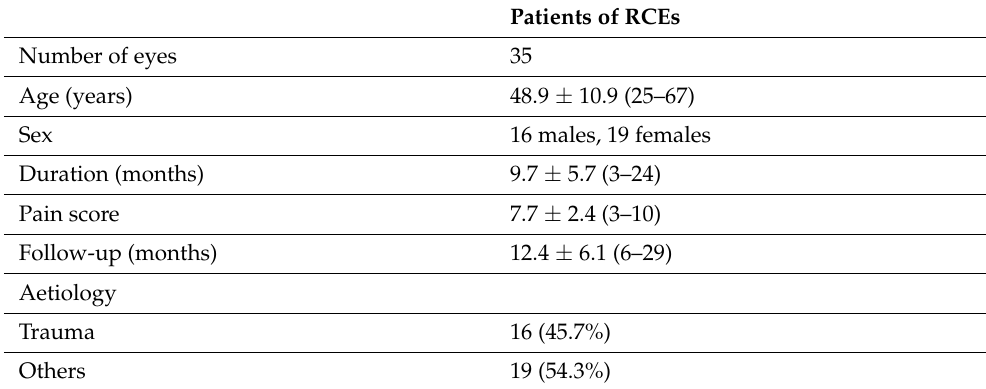
Table 1. Baseline characters of patients of RCEs.